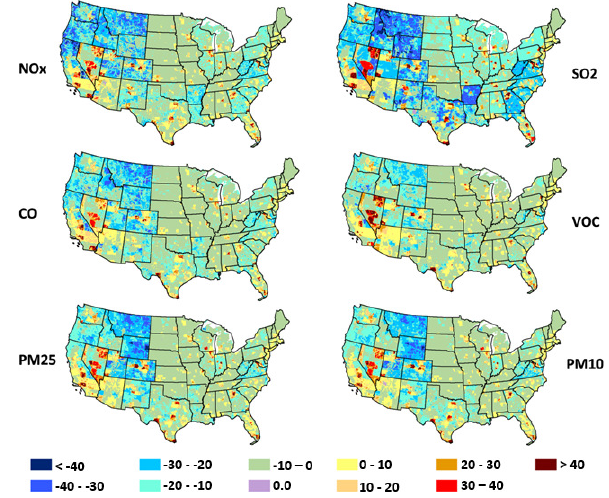
Figure 8. FD (%) of annual emissions, Future minus Base , over the 12km CONUS domain. ( Future : 2050 inventory, 2050 surrogates, county growth factors; Base : 2005 inventory, 2005 surrogates).